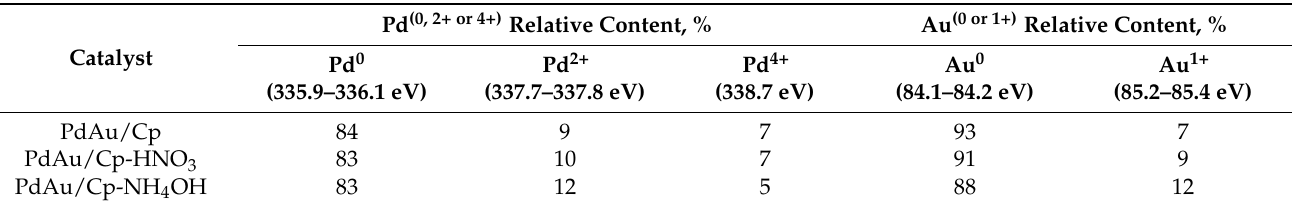
Table 5. Effect of modification of the support on contribution of different electronic states of Pd and Au calculated according to XPS.